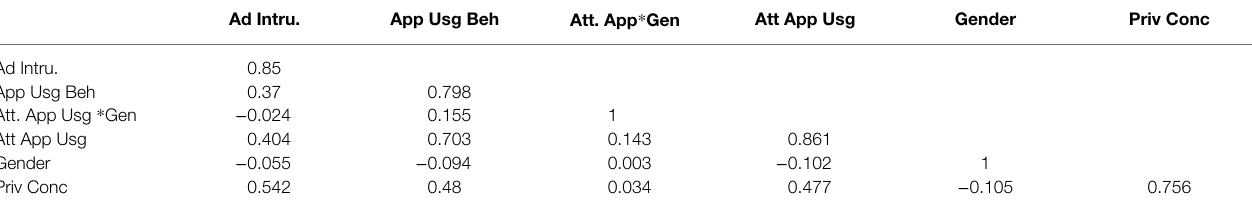
TABLE 3 | Discriminant validity. Ad Intru. App Usg Beh Att. App * Gen Att App Usg Ad